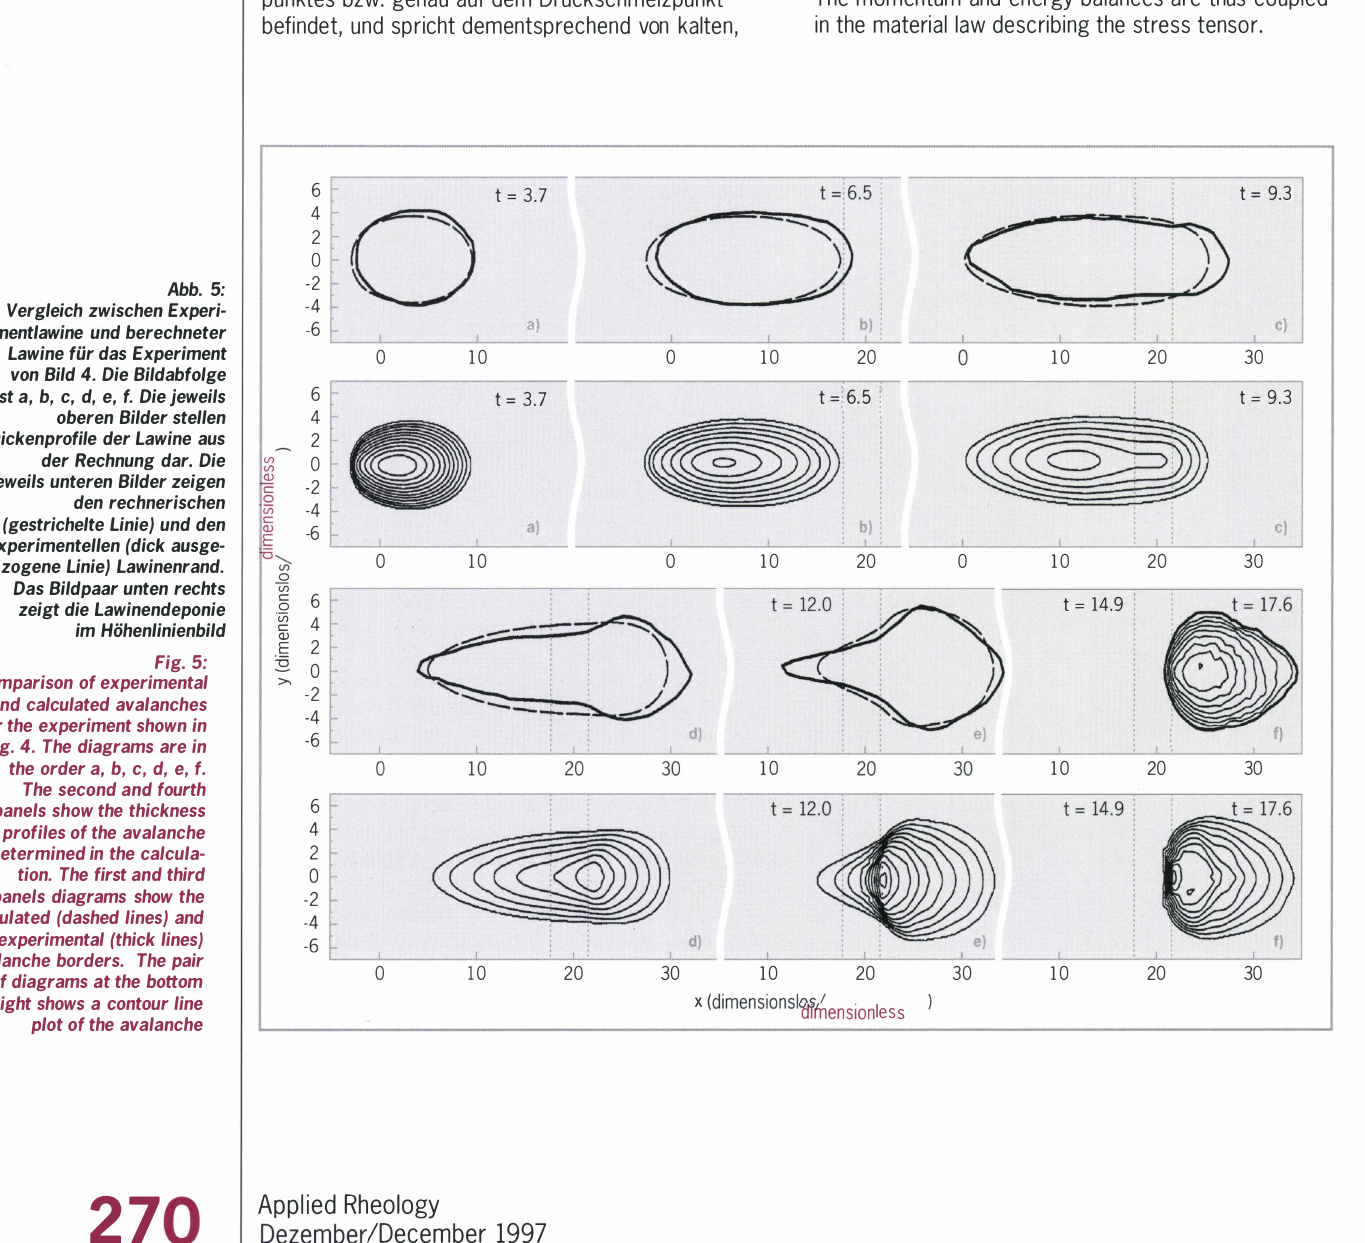
Fig. 5: Comparison of experimental and calculated avalanches for the experiment shown in Fig. 4. The diagrams are in the order a, b, c, d, e, f. The second and fourth panels show the thickness profiles of the avalanche determined in the calcula­ tion. The first and third panels diagrams show the calculated {dashed lines} and experimental {thick lines} avalanche borders. The pair of diagrams at the bottom right shows a contour line plot of the avalanche